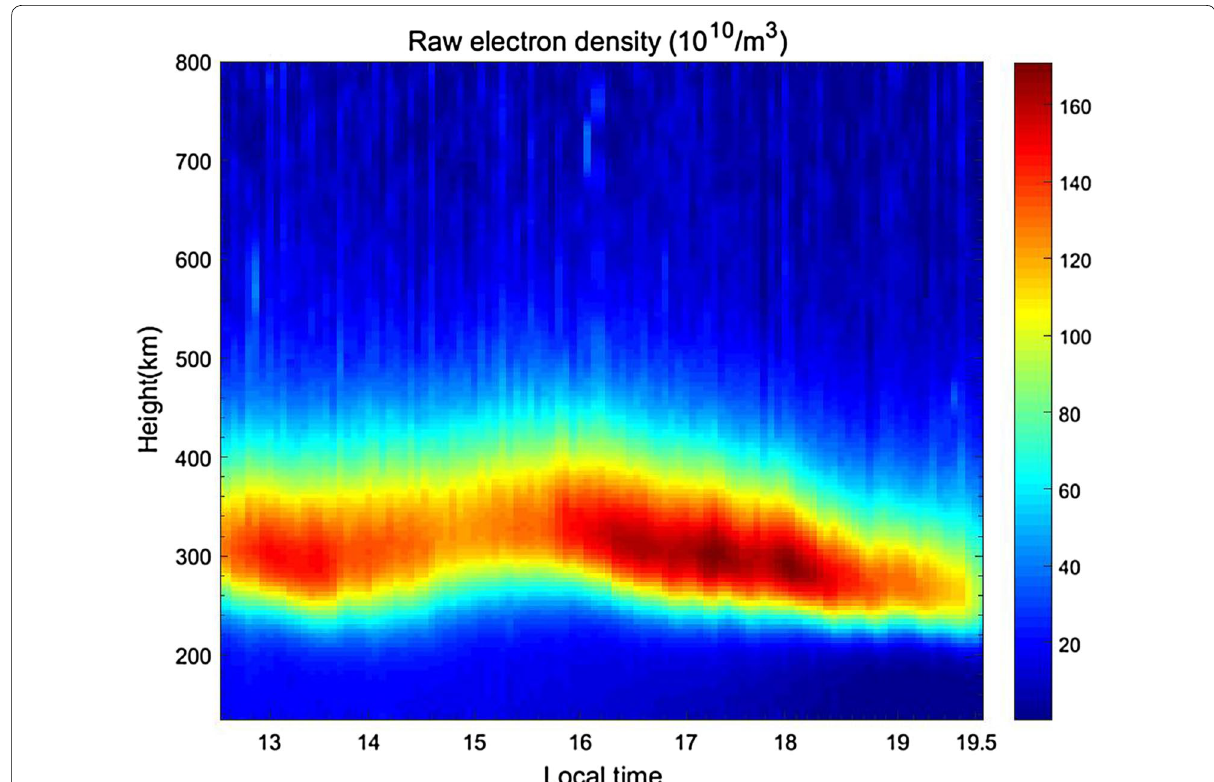
Fig. 12 Daily variation of raw electron density in April